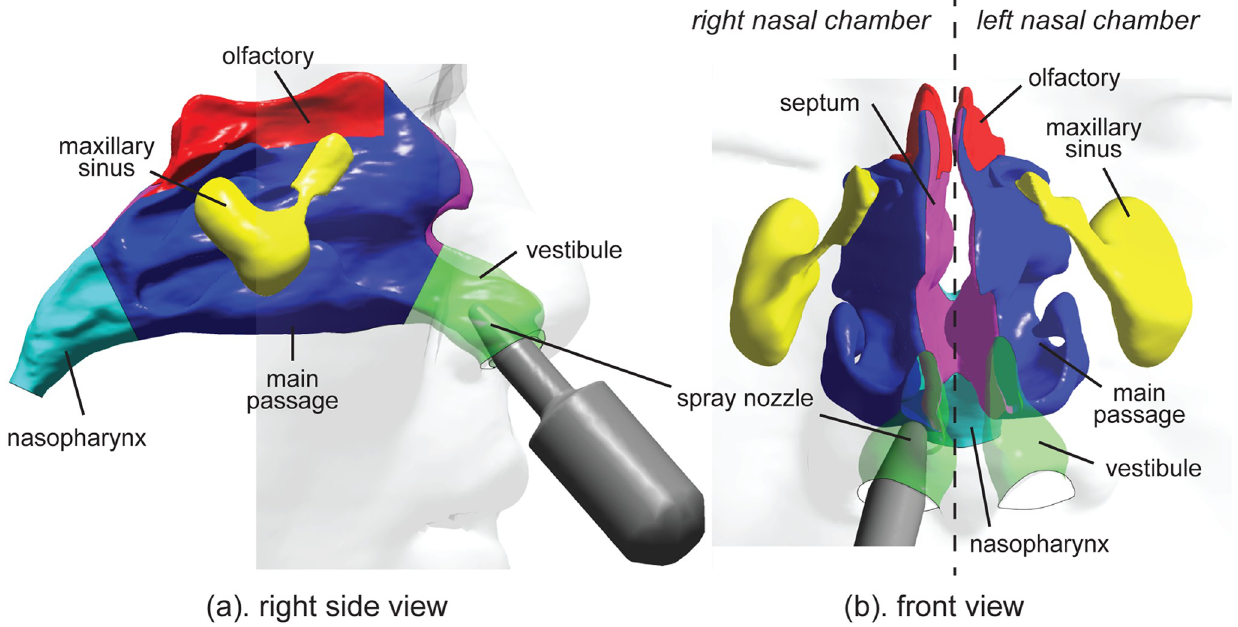
Fig 2. Geometries of the spray bottle, the nasal cavity and its major anatomical regions including vestibules, main passage, septum regions, olfactory regions, maxillary sinuses and nasopharynx.